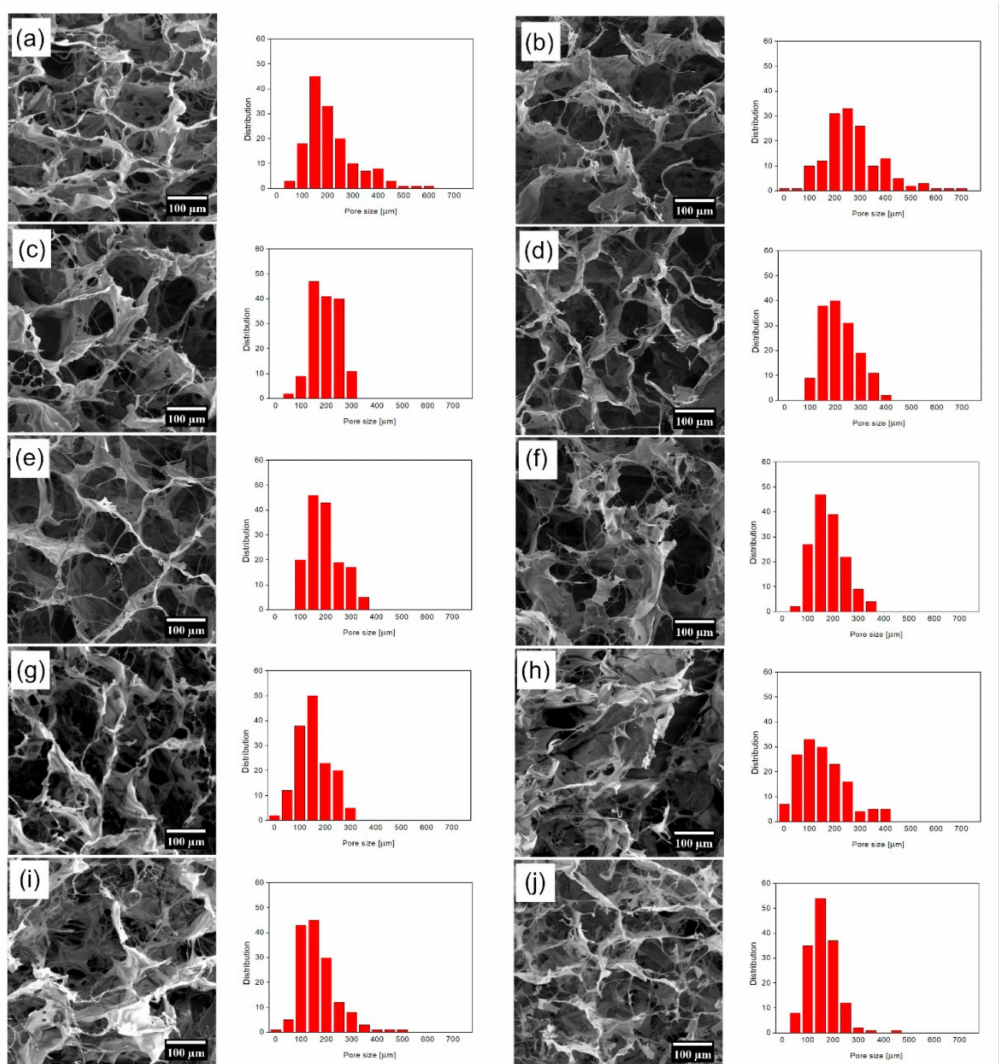
Figure 4. SEM visualization of prepared Coll/Chit scaffold enriched by increasing concentration of FGF2 (left—( a ) Coll/Chit; ( b ) Coll/Chit_0.01 FGF2; ( c ) Coll/Chit_0.05 FGF2; ( d ) Coll/Chit_0.1 FGF2; ( e ) Coll/Chit_0.5 FGF2; ( f ) Coll/Chit_1 FGF2; ( g ) Coll/Chit_5 FGF2; ( h ) Coll/Chit_10 FGF2; ( i ) Coll/Chit_50 FGF2; ( j ) Coll/Chit_100 FGF2) and pore size distribution in the prepared scaffolds